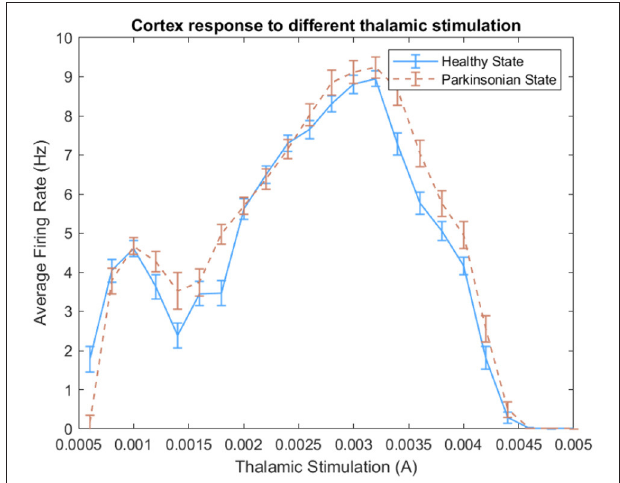
FIGURE 14 | Effect of different thalamic stimulation over cortical neurons. For each thalamic stimulation, we calculated the average firing rate of cortical neurons during an entire experiment and its standard